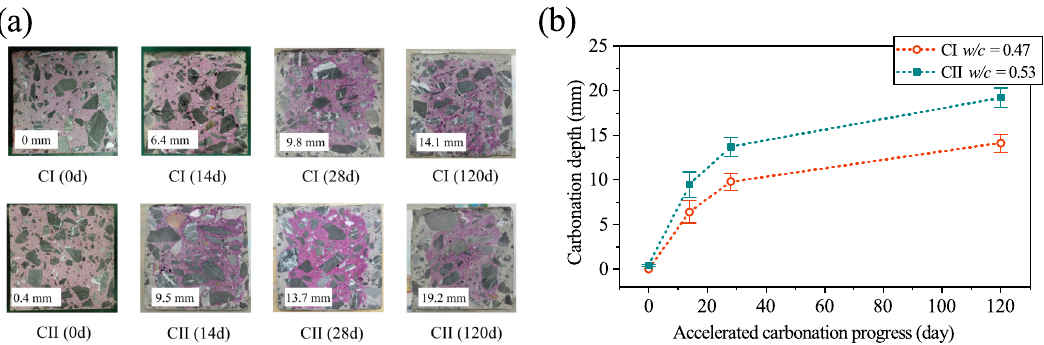
Figure 7. Average carbonation depth: ( a ) carbonated caoncrete ( b ) carbonation depth with accelerated carbonation time depth.